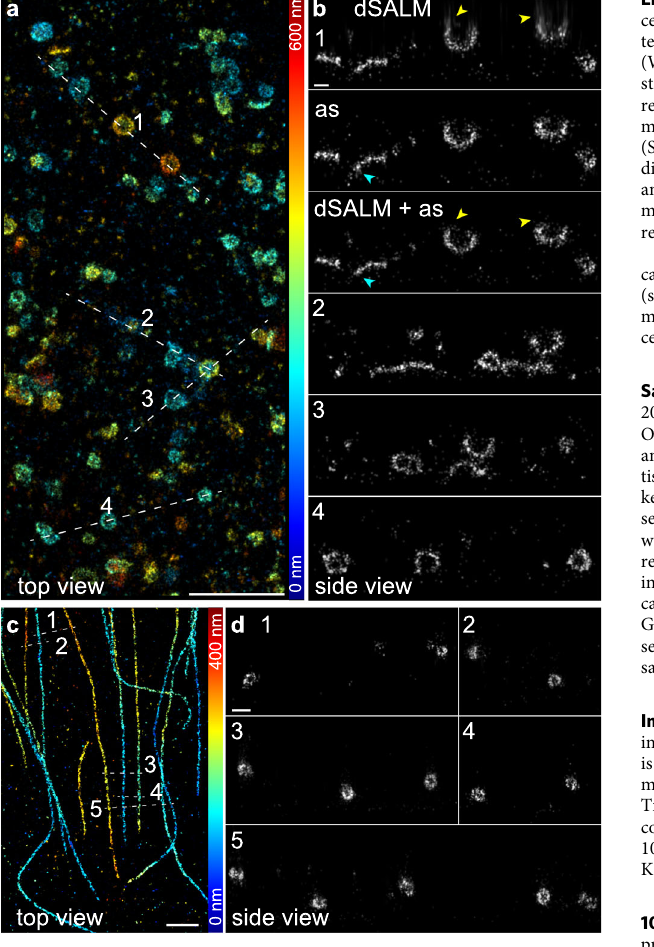
Fig. 4 Application to biological structures. a Clathrin coated pits, labeled with anti-clathrin heavy and light chain primary and speed-optimized DNA- PAINT secondary antibodies. Localizations are color-coded according to their z positions. b Side-view reconstructions of regions as denoted in a (width of the line ROIs 50 nm). b1 shows a comparison of a dSALM reconstruction ( z dSALM ), a reconstruction based on astigmatism ( z as ), and a combined dSALM + astigmatism reconstruction ( z av ). Yellow arrows indicate regions where the combined image shows an improved resolution compared to dSALM alone, cyan arrows indicate regions where the combined image shows a higher resolution than astigmatism alone. b2 – 4 are based on z av . See Supplementary Fig. 5 for additional reconstructions and localization precision histograms. c Microtubules, labeled with anti alpha-tubulin primary and speed-optimized DNA-PAINT secondary antibodies. d Side-view reconstructions of regions as denoted in c (width of the line ROIs 200 nm). Scale bars: 1 µ m ( a , c ), 100 nm ( b , d ). Both a and c are representative images from two independent experiments